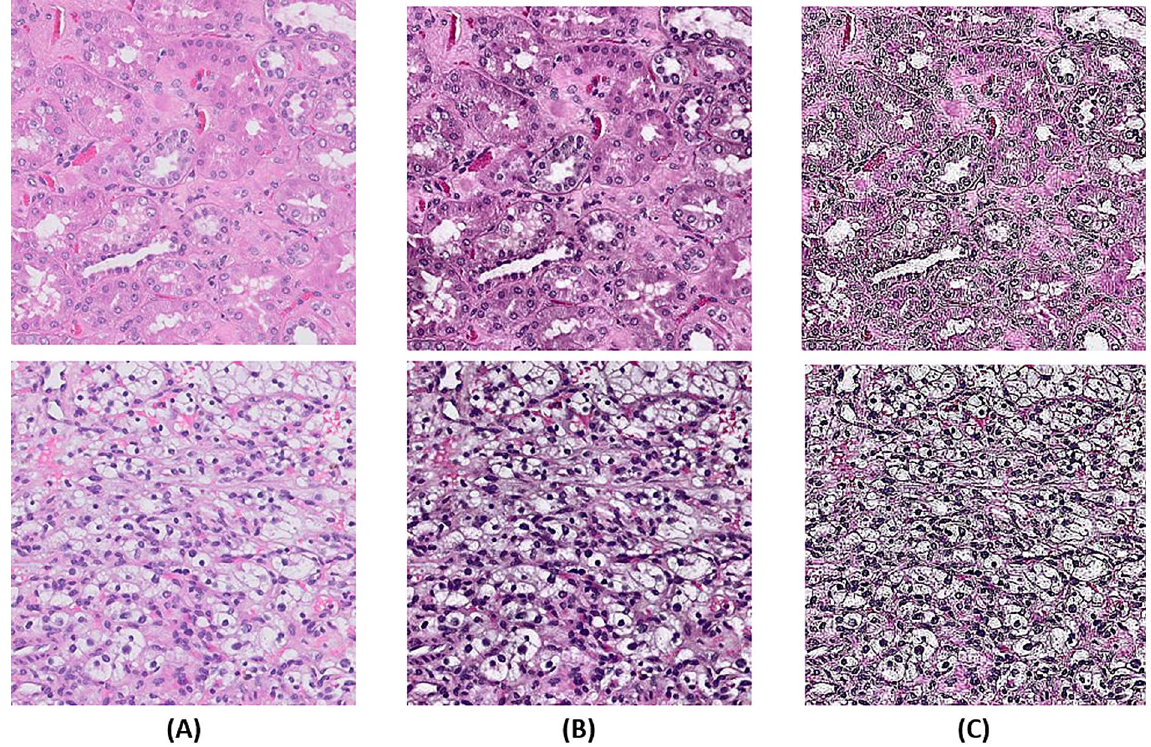
Figure 3. Examples of preprocessing step where original patches are shown in ( A ) and their histogram equalized versions are in ( B ) followed by edge enhancement ( C ).